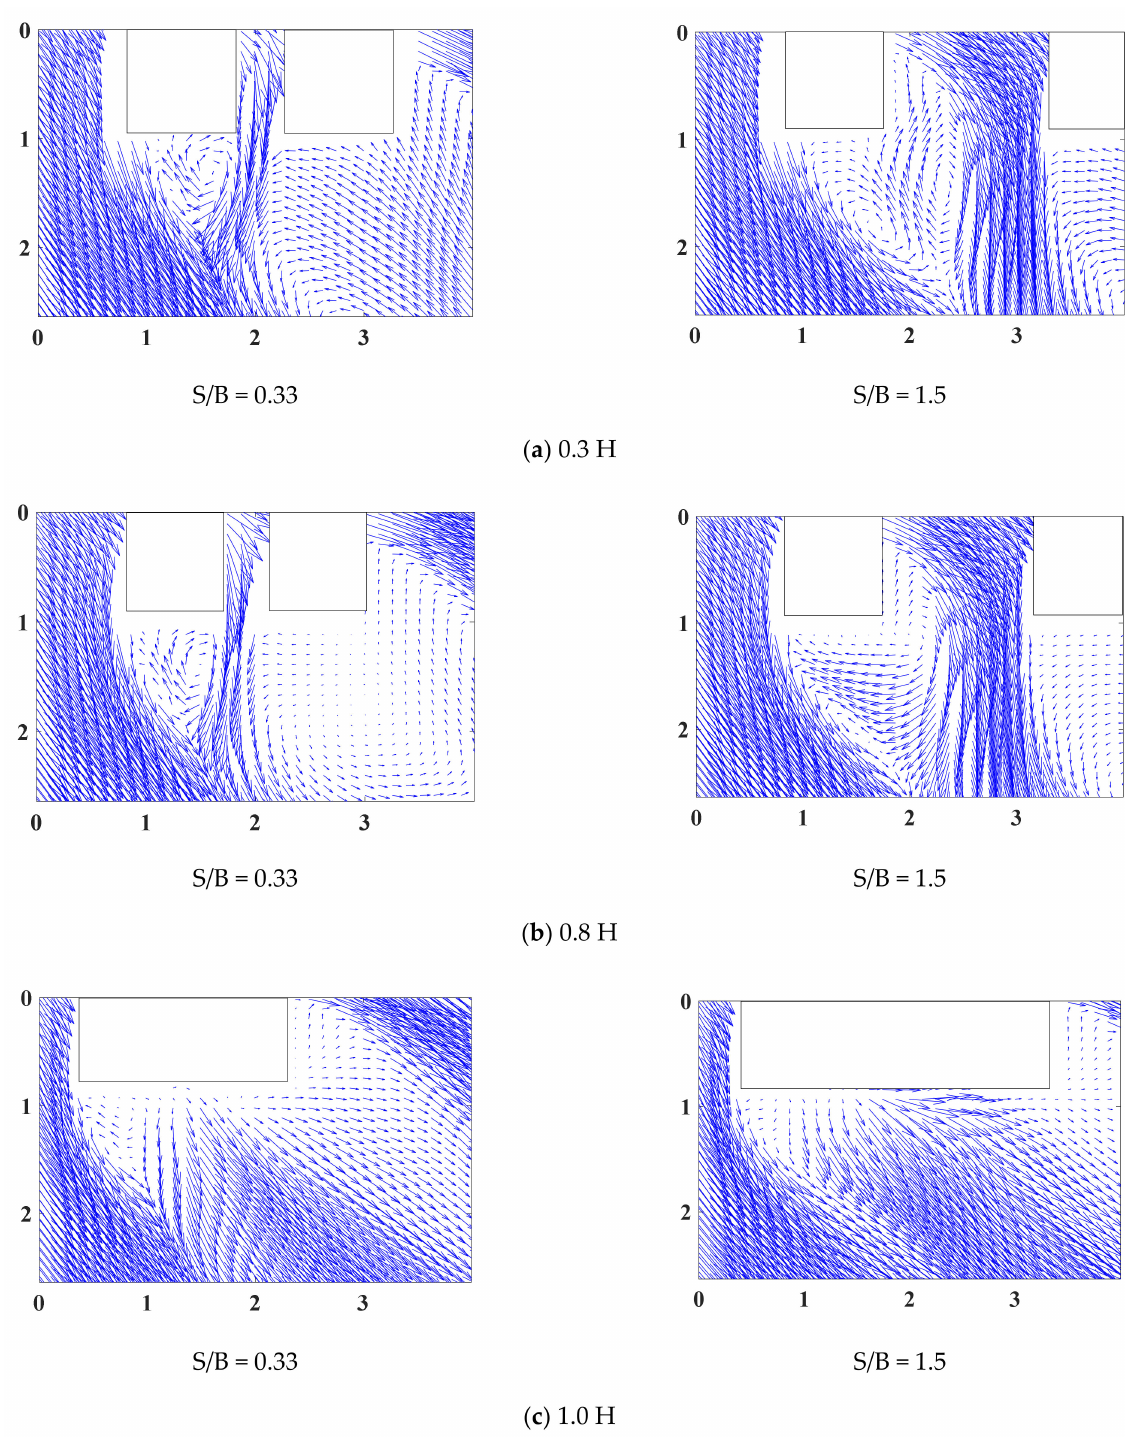
Figure 8. Mean velocity vectors around the LB